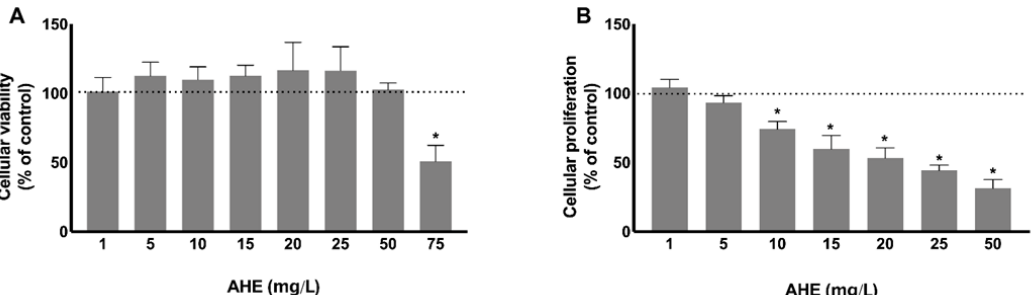
Figure 2. Cytotoxicity and antiproliferative capacity were assessed in HMEC-1 treated with different concentrations of AHE during 24 h. Metabolic activity was determined by MTS assay ( A ). AHE induces cytotoxicity at the highest concentration tested (75 mg/L), in comparison to control. Proliferation was evaluated by BrdU incorporation ( B ). There is an inhibition on HMEC-1 proliferation after treatment with AHE, in a dose-dependent manner. Results are expressed as % of control group. * p < 0.05 vs. control.